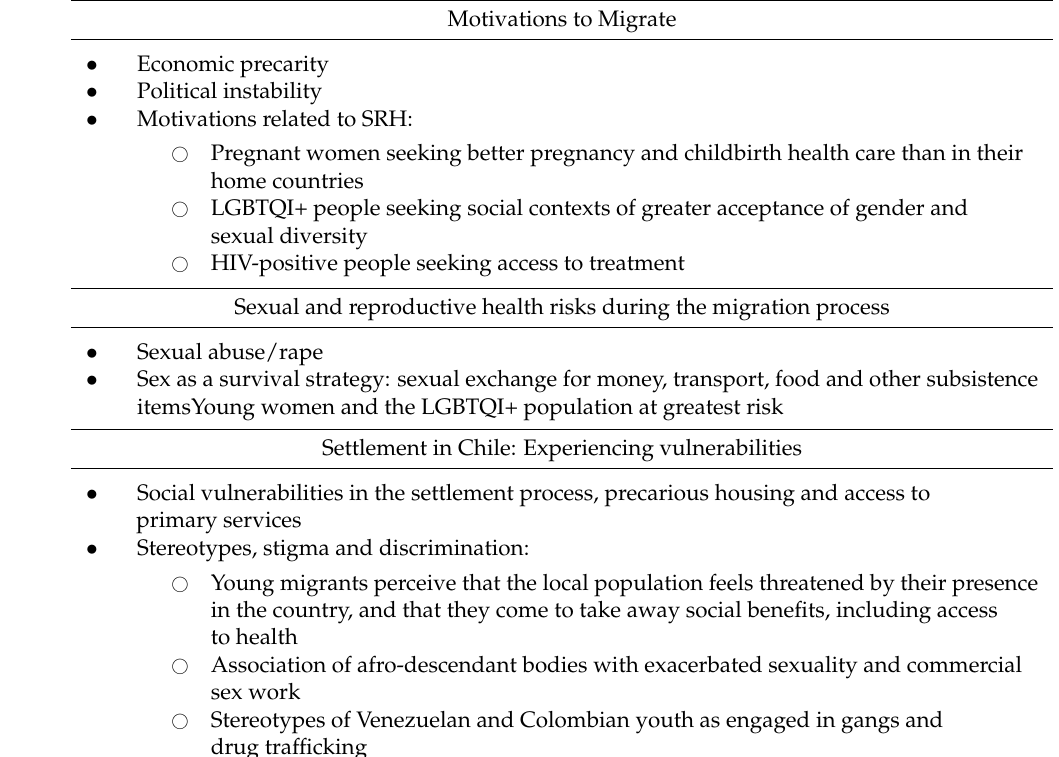
Table 1. Summary of main study